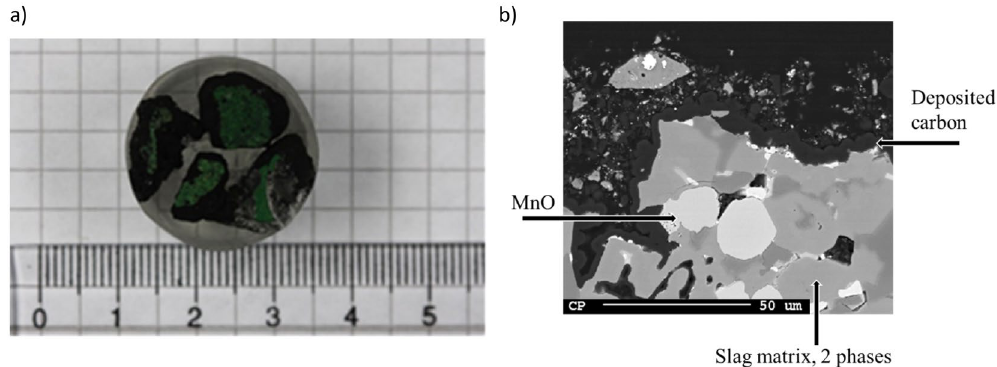
Figure 4. Example images of samples showing deposited carbon, both from experiment 6 (1000 °C, 90%CH 4 – 10% Ar, 2.35 L/min). ( a ) Macroscopic image showing black layers on the greenish slag. ( b ) ×500 magnification back scatter EPMA image showing the different slag-phases and the deposited carbon layer. The phases were verified by X-ray diffraction.